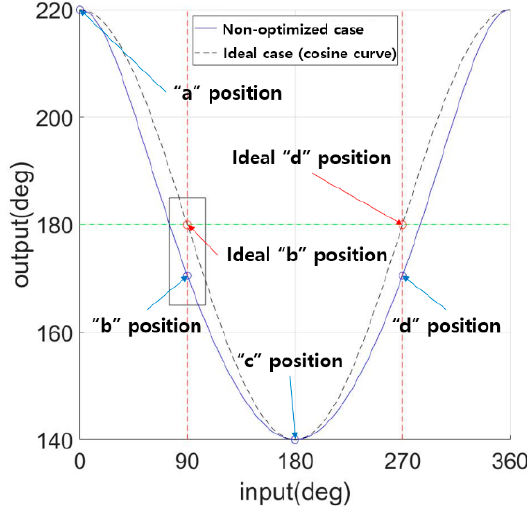
Figure 5. The secondary condition. A non ‐ optimized case and an ideal case are simultaneously shown to compare the